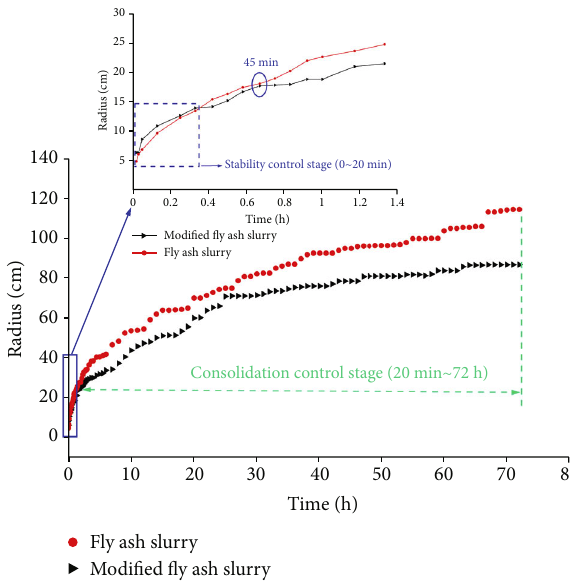
Figure 9: Two-stage e ff ect of di ff usion radius of modi fi ed fl y ash slurry.